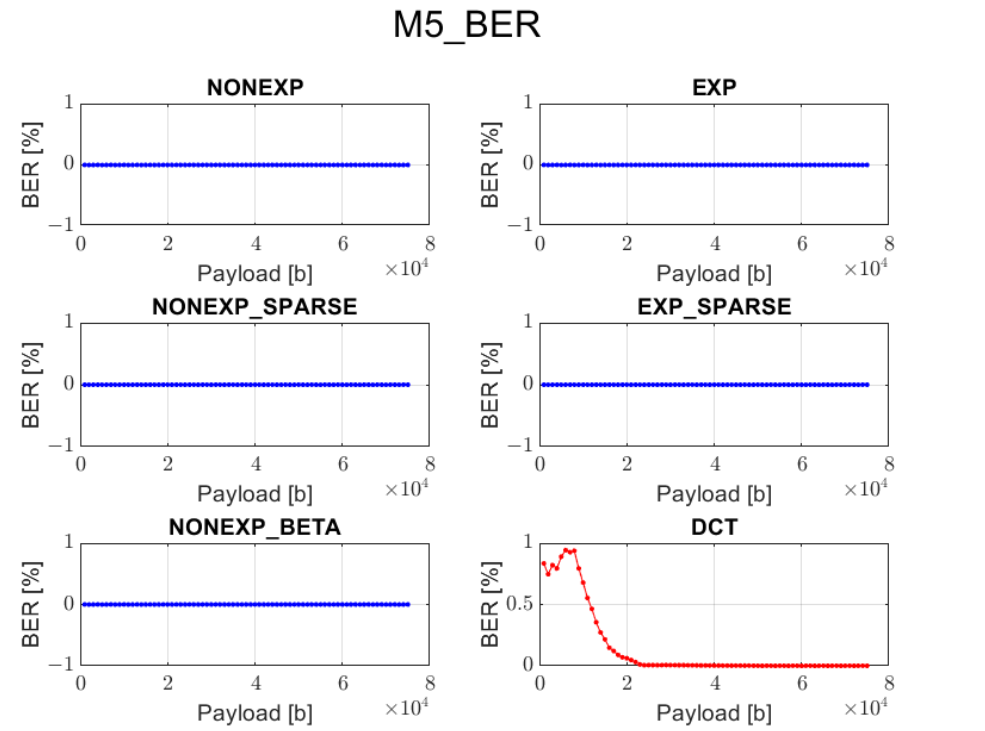
Figure 11. Relation between BER and embedded data size for method 5 and all transform types. As an example, the watermarked image for one of the test images is shown in Figure